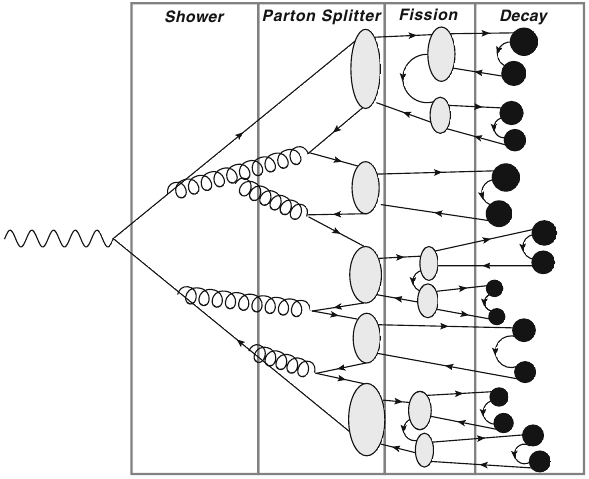
Fig. 1 Figure of a simplified event where we show the major stages of hadronization after the parton shower that can contribute to non- perturbative strangeness production. Grey ellipses are clusters, while black are